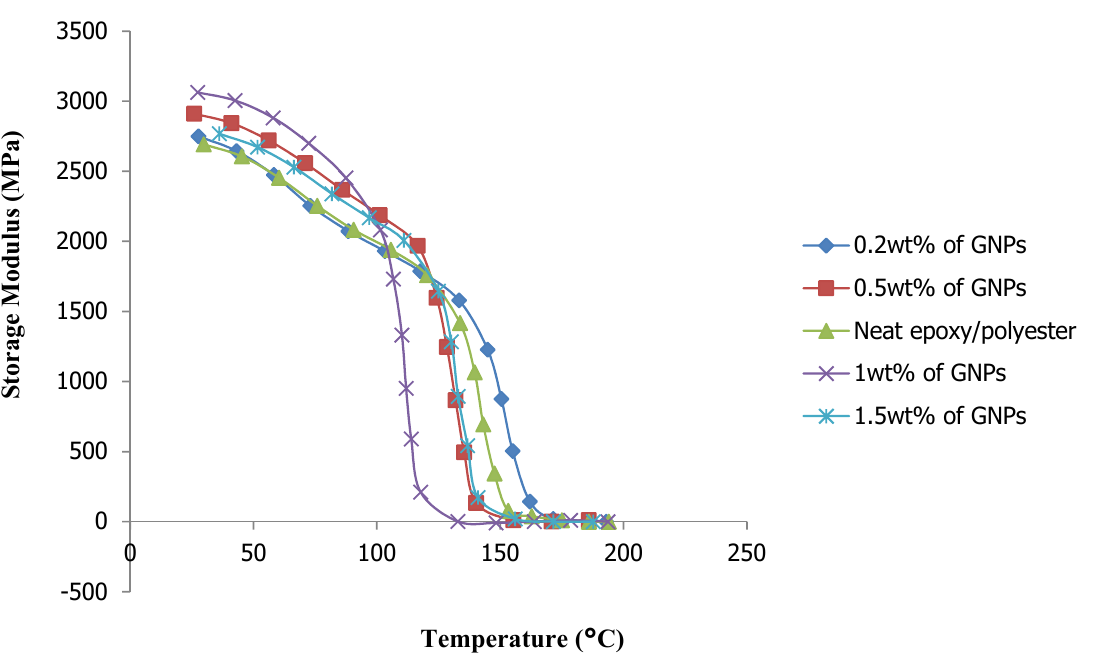
Figure 5. Storage modulus vs. temperature plots of GNP/epoxy/polyester nanocomposite.